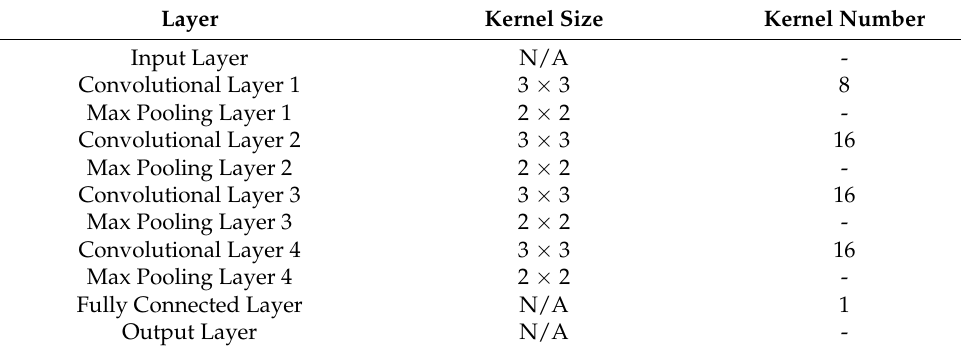
Figure 7. The SOH estimation process using wavelet transform and neural network. Table 2. Construction of the CNN model for SOH estimation.